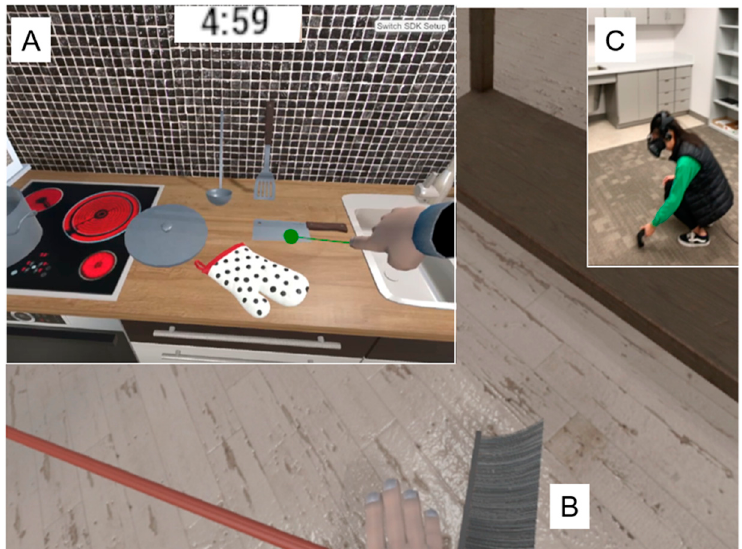
Figure 2. iVR Kitchen interactions. ( A ) Participants used their handset to point to any item and hear their corresponding Chinese word. Across both iVR Kitchen and Zoo conditions, timers briefly appeared every five minutes and during the last five seconds to indicate the time remaining. ( B ) Individuals could pick up and move objects by pressing a trigger button with their index finger. ( C ) Position of an individual picking up the item (broom) shown in panel B.